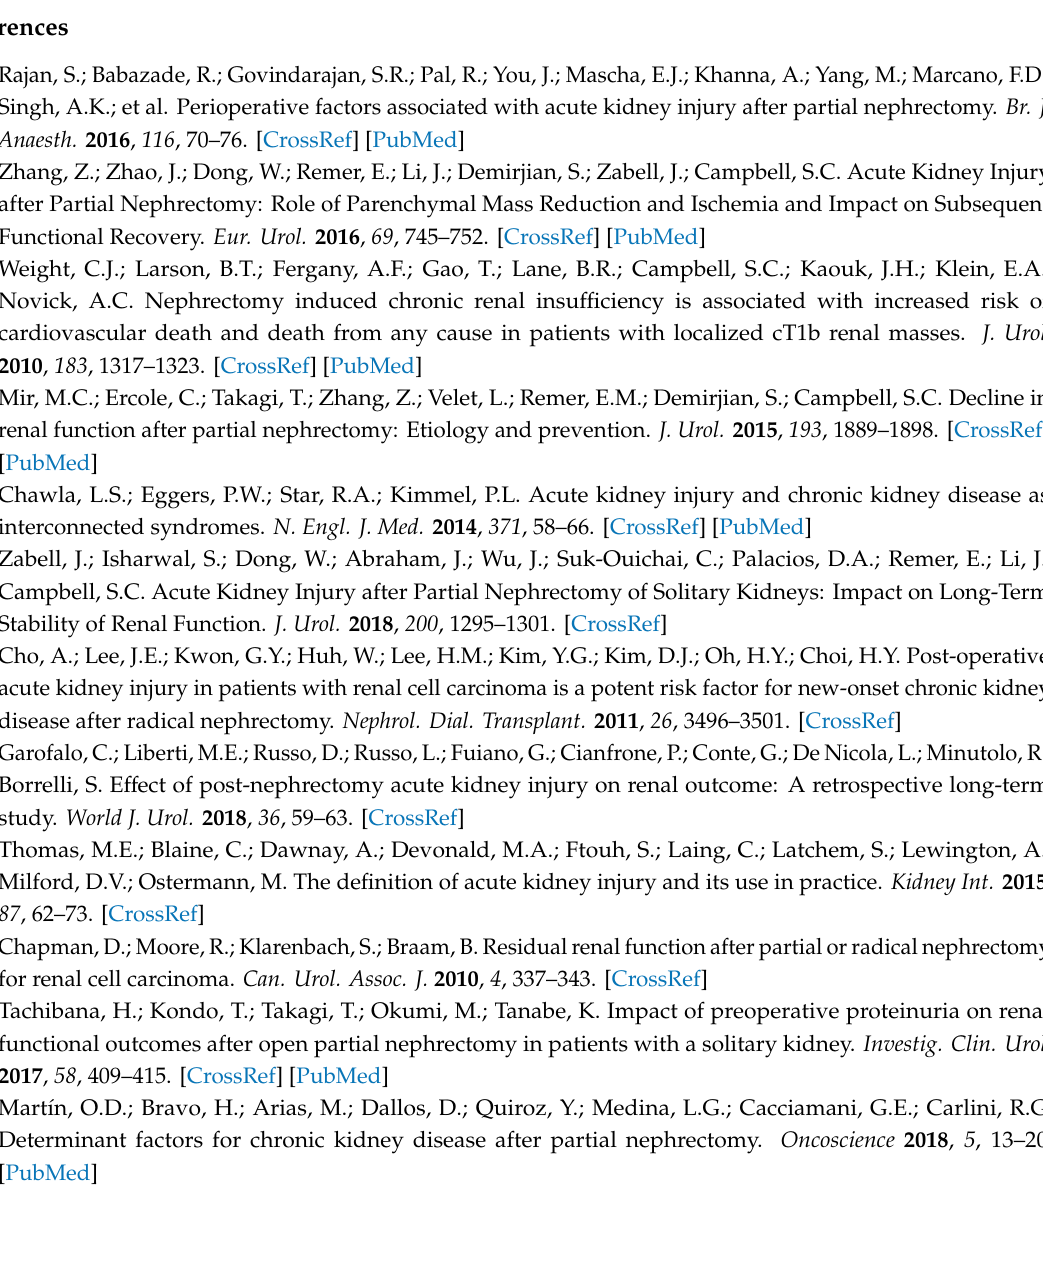
Table S2. Comparison of baseline renal function and the rates of surgical complications between those with and without adjusted acute kidney